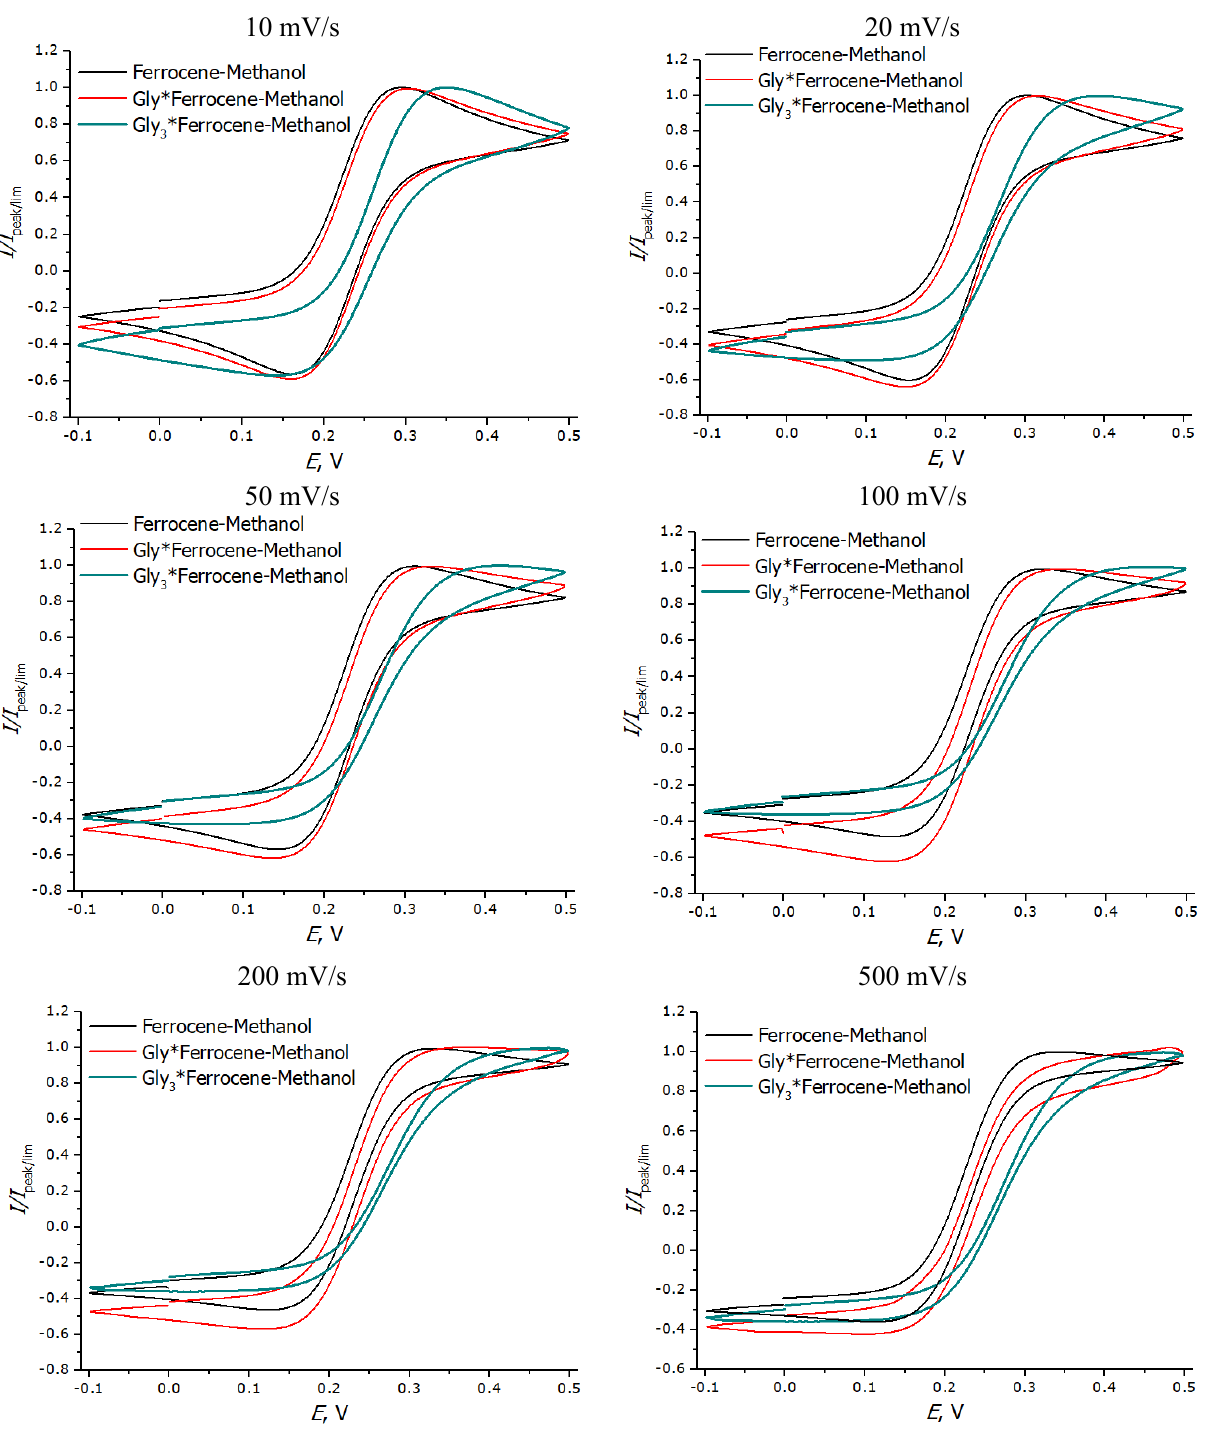
Figure 16. Experimentally obtained cyclic voltammograms of ferrocenemethanol and its esters with glycine and triglycine.